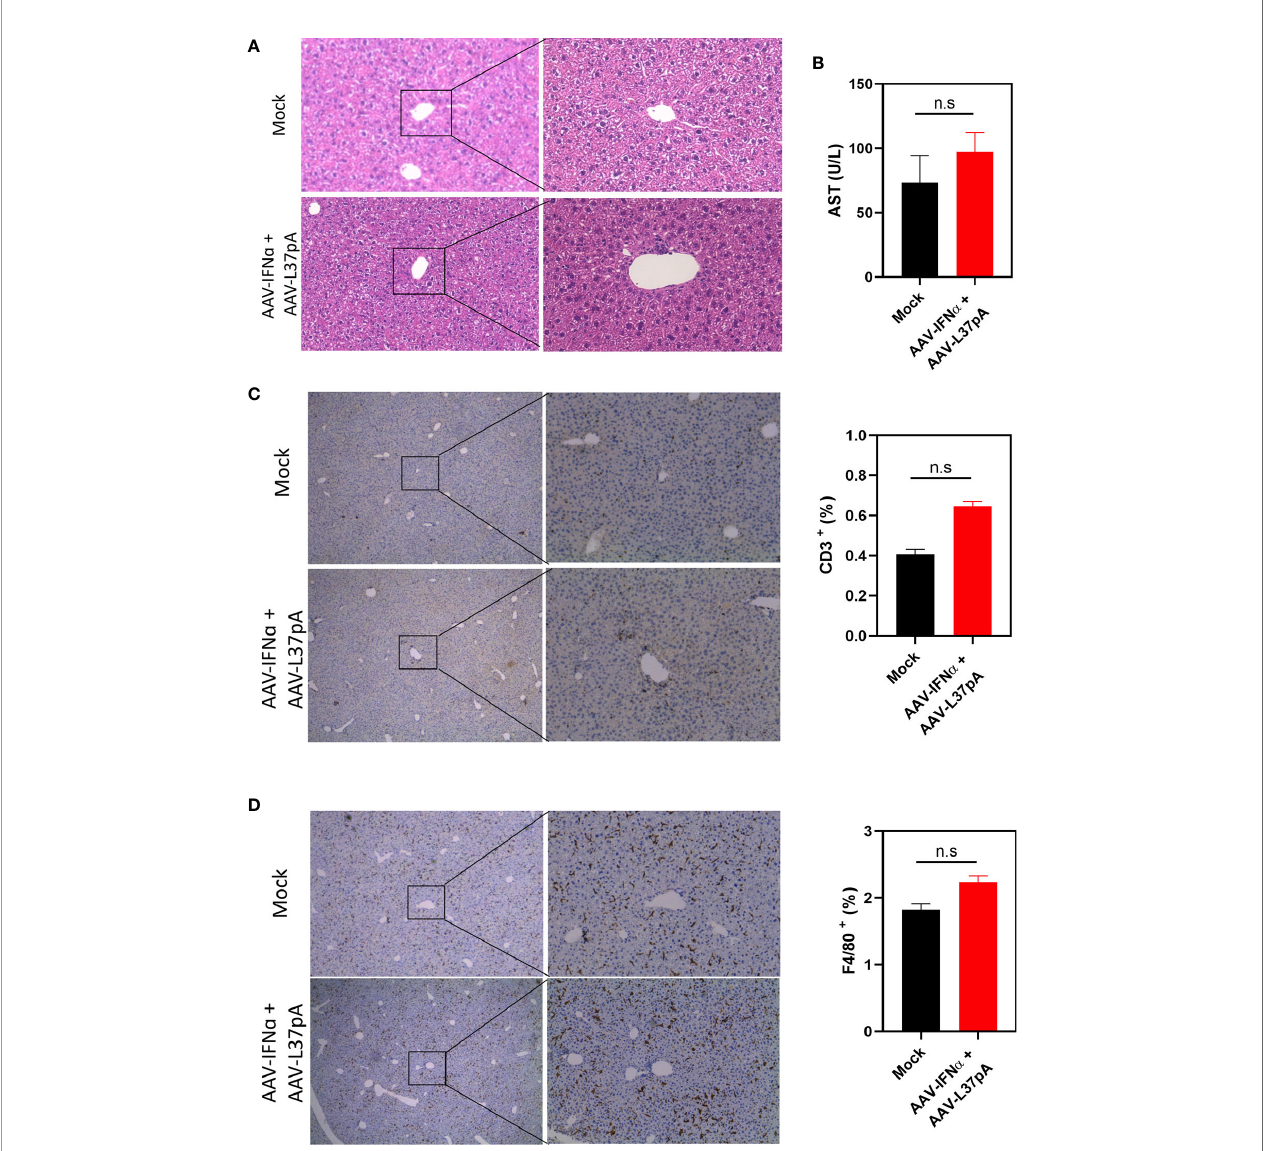
FIGURE 5 | Long-term expression of AAV-IFN a and AAV-L37pA does not induce alterations in the liver. C57BL/6 mice (N = 6) were left untreated (mock) or received 1.2x10 11 vg/mouse of AAV-IFN a combined with 9.5x10 11 vg/mouse AAV-L37pA. Mice were followed for 120 days and then sacri fi ced. (A) The histology of the liver was analyzed by hematoxylin and Eosin staining. (B) Aspartate transaminase (AST) serum levels. (C) Representative image of intrahepatic T lymphocytes identi fi ed by immunohistochemistry against CD3 and quanti fi cation of T lymphocytes in the liver. (D) Representative image of intrahepatic macrophages identi fi ed by immunohistochemistry against anti-F4/80 and quanti fi cation of macrophages in the liver. Mean ± SEM is represented. n.s, non-signi fi cant. Student